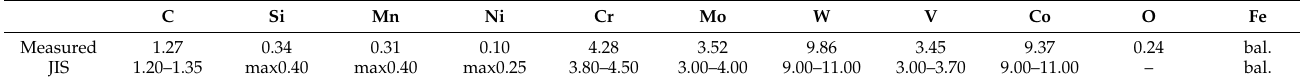
Table 1. Chemical compositions of SKH57 raw powders (mass%).